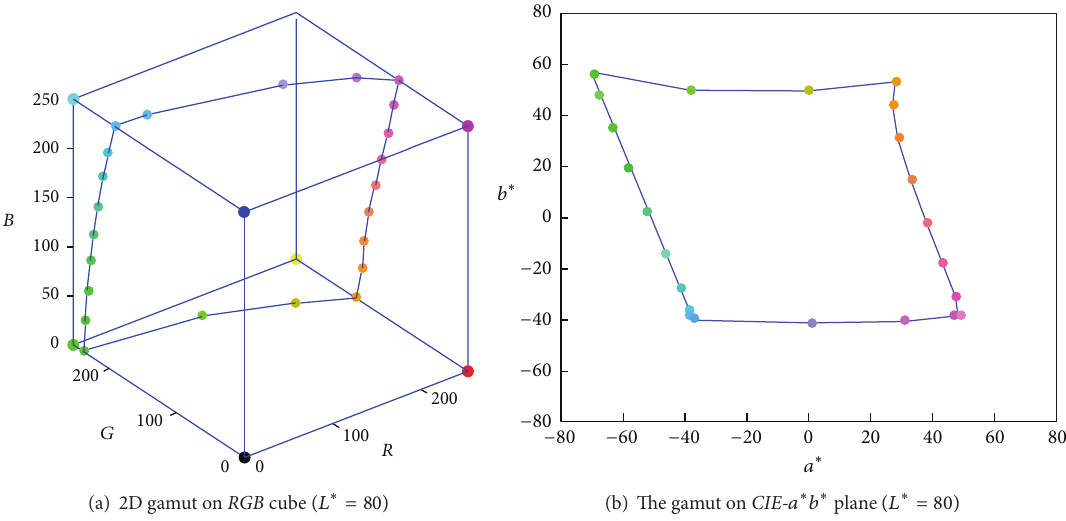
Figure 5: The constant-lightness gamut on RGB cube and CIELAB